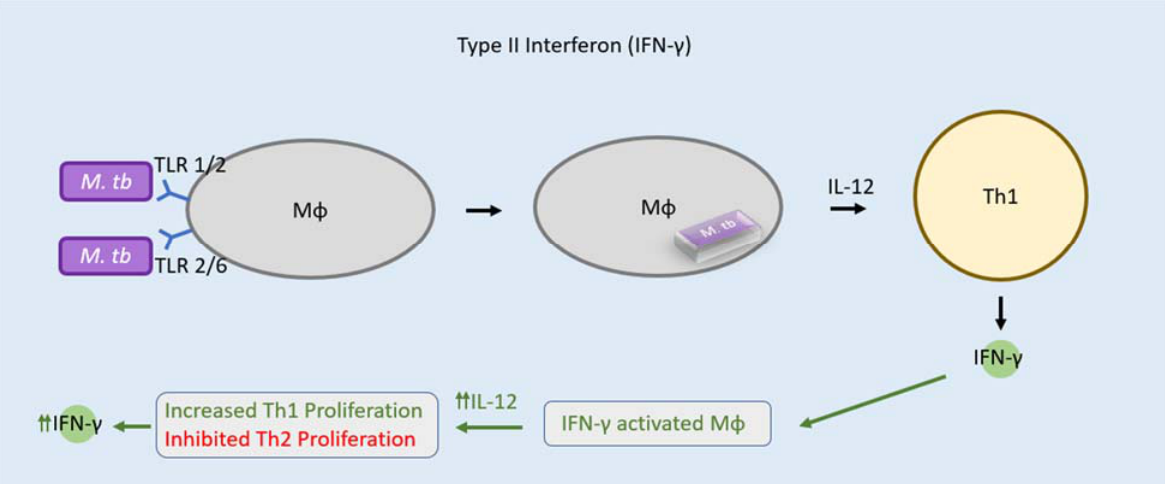
Figure 2. Mechanism of action of type 2 IFNs. Type II IFN is the primary mediator which activates macrophages to produce reactive nitrogen species. Macrophages recognize M. tb using Toll ‐ like receptors (TLR) and phagocytose the bacteria. Macrophages release IL ‐ 12 which drive Th1 cells to release type II IFN. The type II IFN receptor is made of the subunits IFN ‐ ɣ R1 and IFN ‐ ɣ R2 associated with JAK1 and JAK2, respectively. Activation results in formation of STAT1 homodimers that bind GAS in the nucleus.